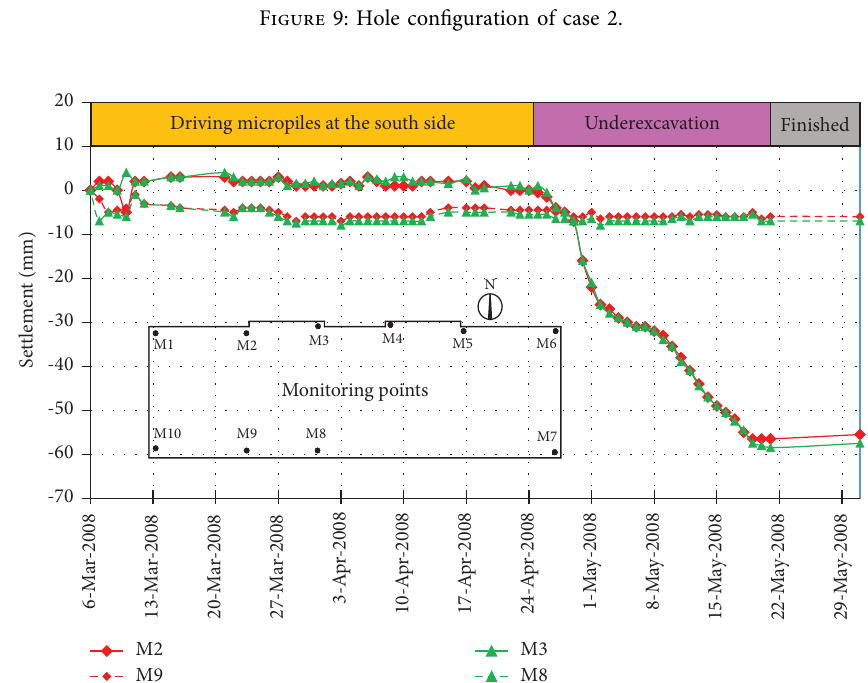
Figure 10: Settlement versus time of case